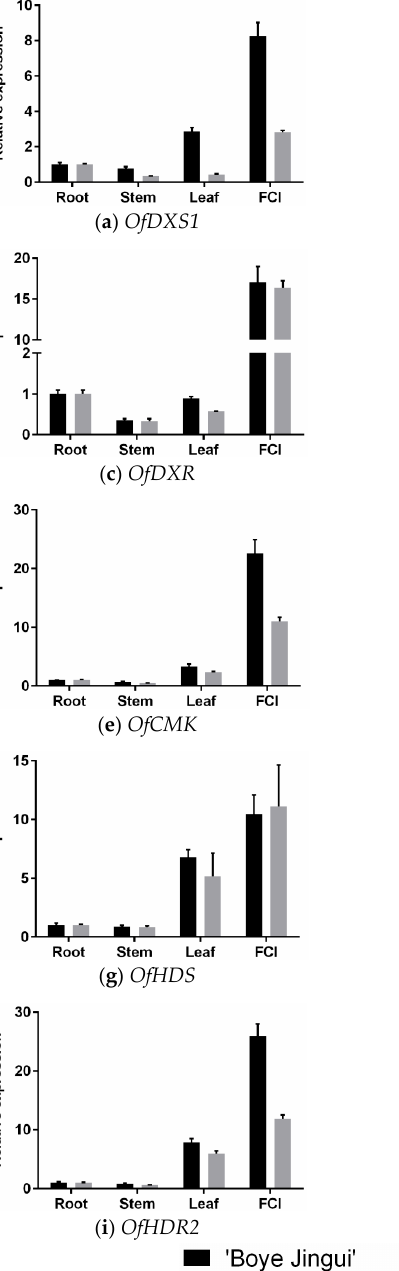
Figure 3. Expression patterns of MEP pathway genes in four different organs of Osmanthus fragrans . FCI: florets of cymose inflorescences at full blooming stage. Data were presented as means with error bars indicating standard deviation.